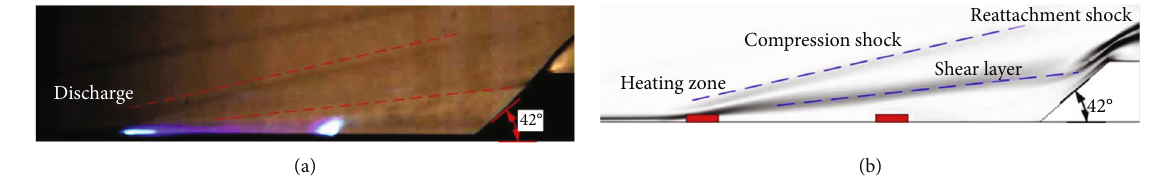
Figure 6: Comparison of the experimental schlieren image and the numerical density gradient contour. (a) The experimental schlieren image. (b) The density gradient contour using the current numerical method.